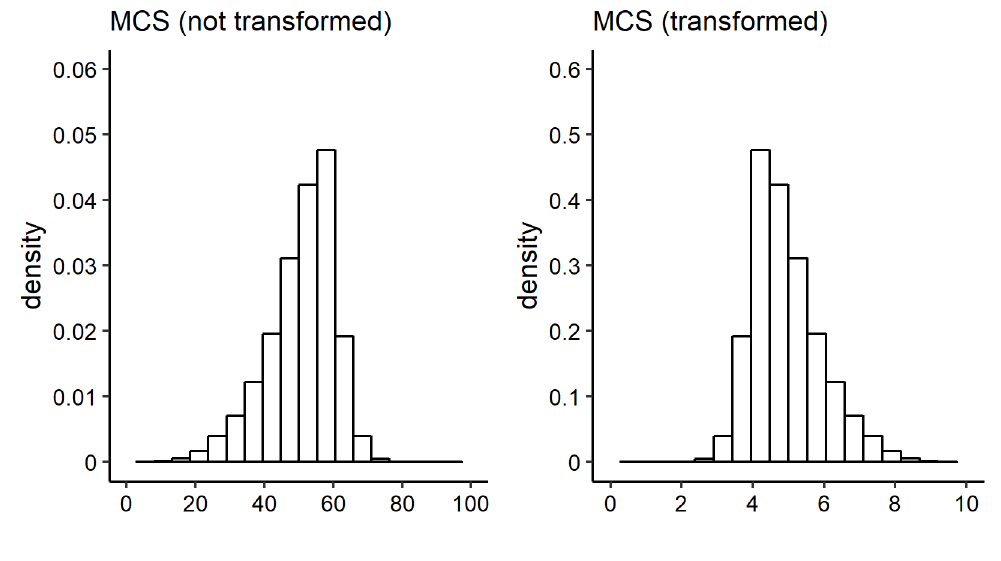
Figure 2. Histogram of MCS scores. Left: not transformed, right: